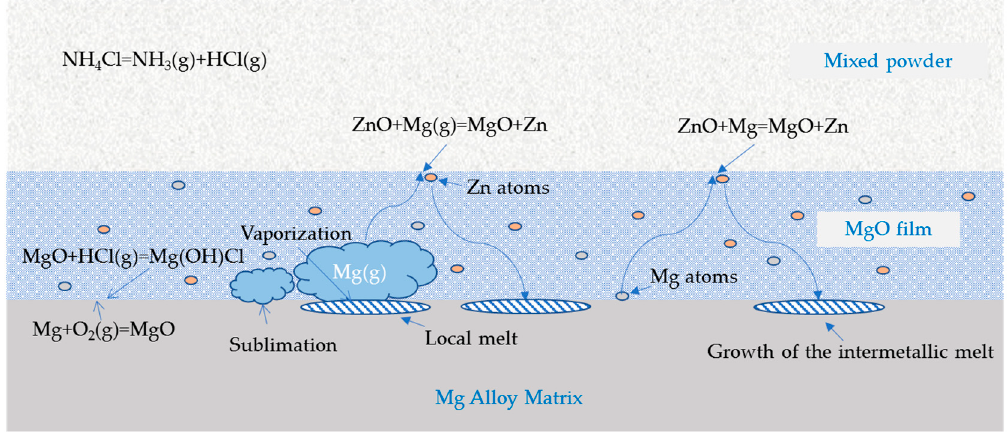
Figure 7. Schematic diagram of the in-situ reduction of ZnO by the active Mg.